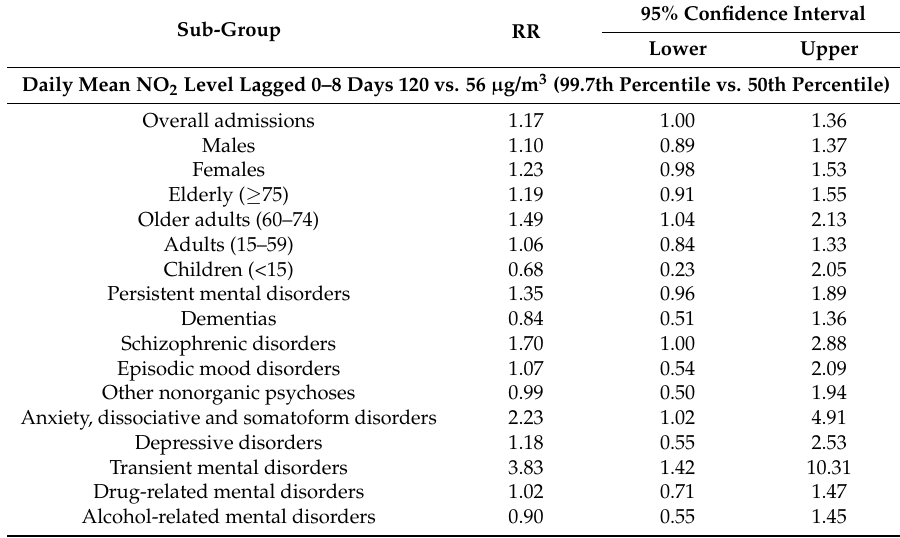
Table A1. Regression results for NO2 with overall mental disorders admissions and subgroup admissions in Hong Kong,